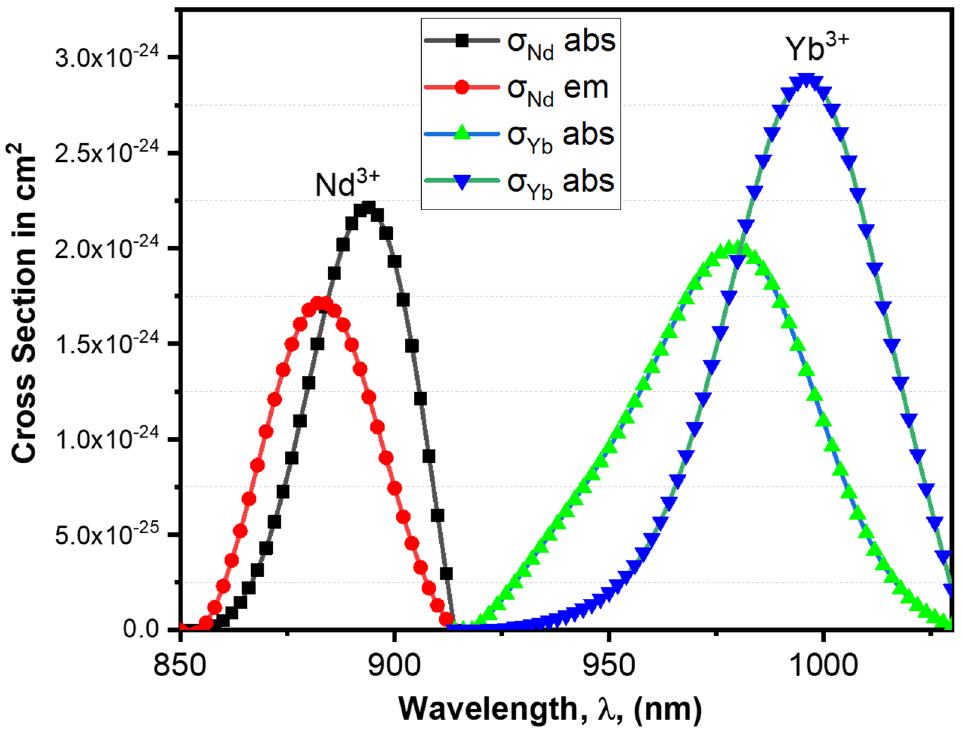
Figure 6. Absorption and emission cross section of prepared glass PZLBNdYb.